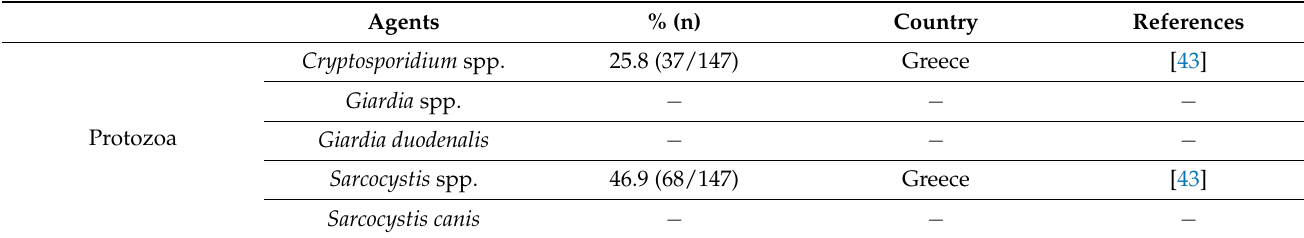
Table 6. Cont. Agents % (n)